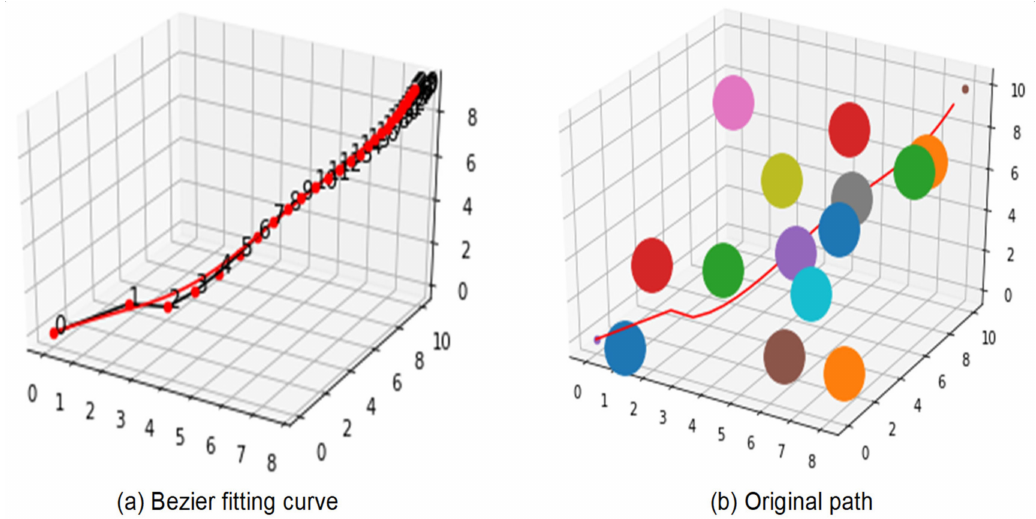
Figure 9. Comparison of the Bezier fitted curve and original path.